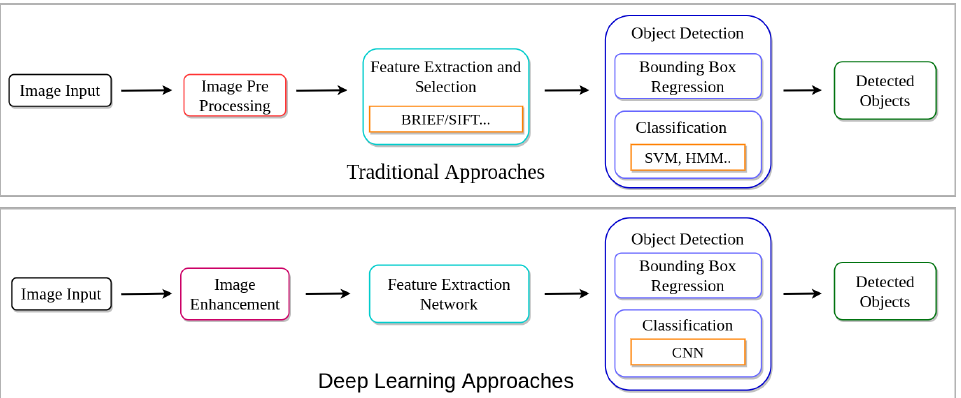
Figure 3. Pipeline comparison of traditional and deep learning approaches for object